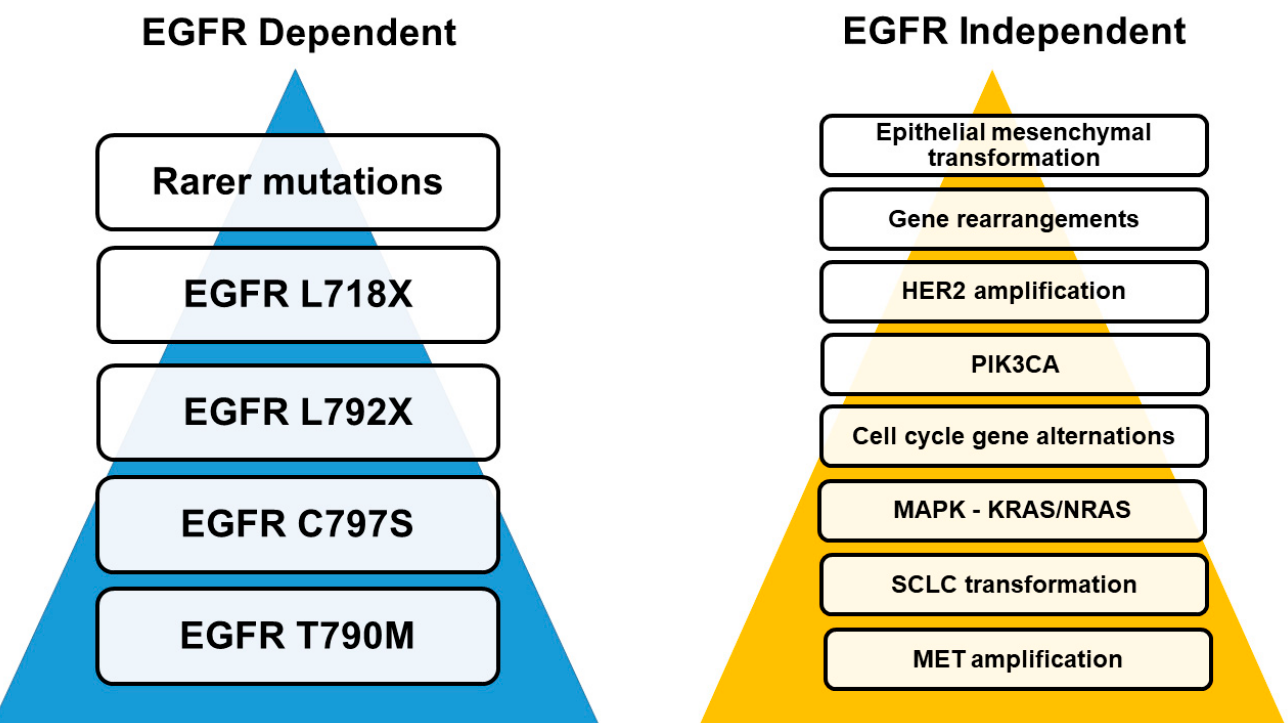
Figure 4. An overview of mutations involved in TKIs resistance. They are divided into EGFR- dependent mechanisms (on the blue pyramid) and EGFR-independent mutations (on the yellow pyramid). They are sorted in ascending order based on their frequency. The most frequent aberration lies at the bottom of each pyramid. SCLC: Small Cell Lung Cancer.